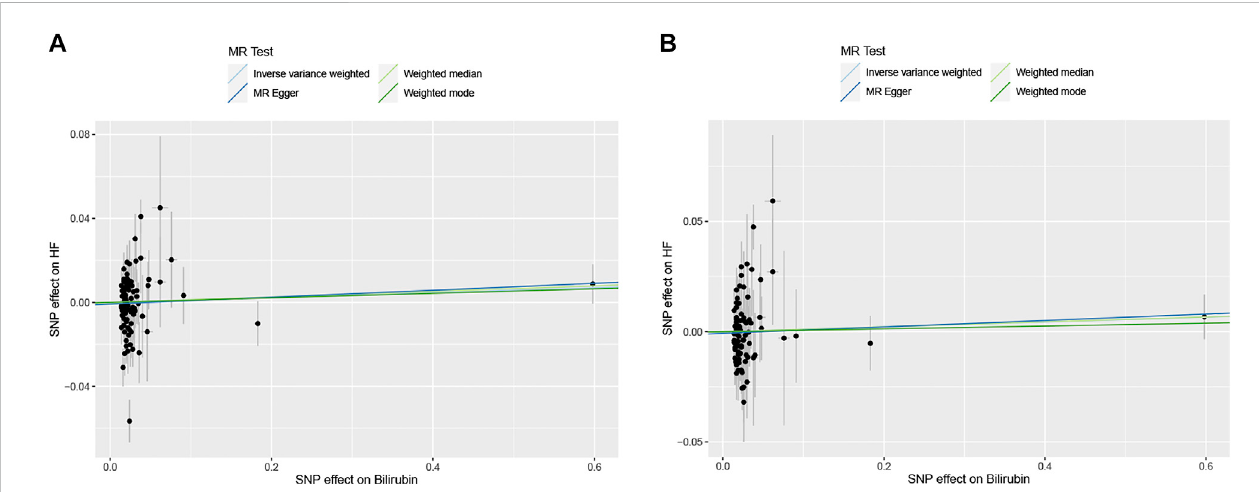
FIGURE 2 The scatter plots of serum bilirubin-associated single nucleotide polymorphisms (SNPs) effects on heart failure (HF) in HERMES Consortium (A) and FinnGen Study (B) . The 95% CI for the effect size on HF is shown as vertical lines, while the 95% CI for the effect size on bilirubin level is shown as horizontal lines. The slope of fi tted lines represents the estimated Mendelian randomization (MR) effect per method.